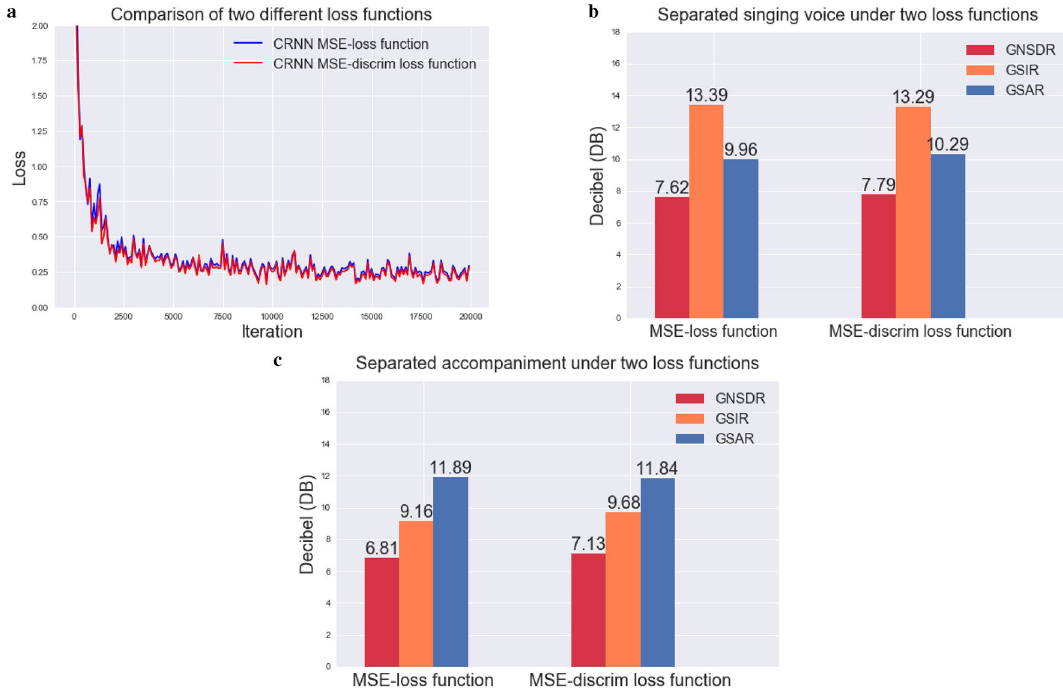
Figure 6. The influence of loss function on separation performance.